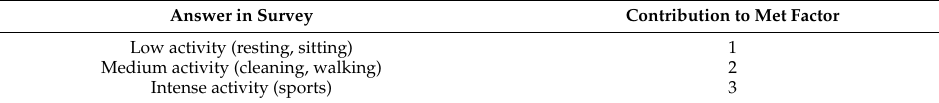
Table 4. Met factor according to answers in the survey.